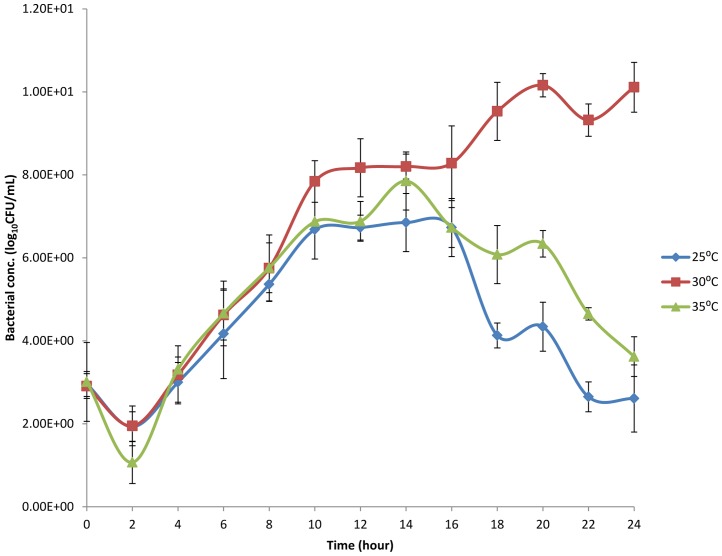
Growth curve of MWI-1 in a metal-free medium (HMC broth) inoculated at different temperatures (25°C, 30°C, 35°C) at pH 7.2±0.2 for 24 h.